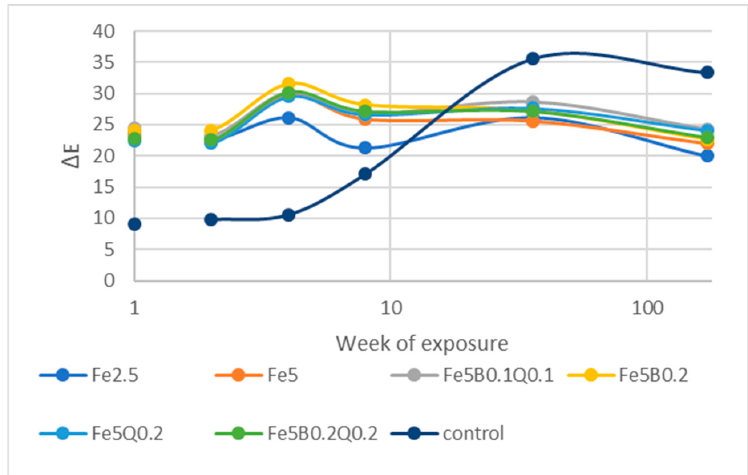
Figure 4. Mean colour change ( Δ E) of control and treated Norway spruce samples following outdoor exposure. The compositions of treatments are presented in Table 1. The x -axis is a logarithmic scale.